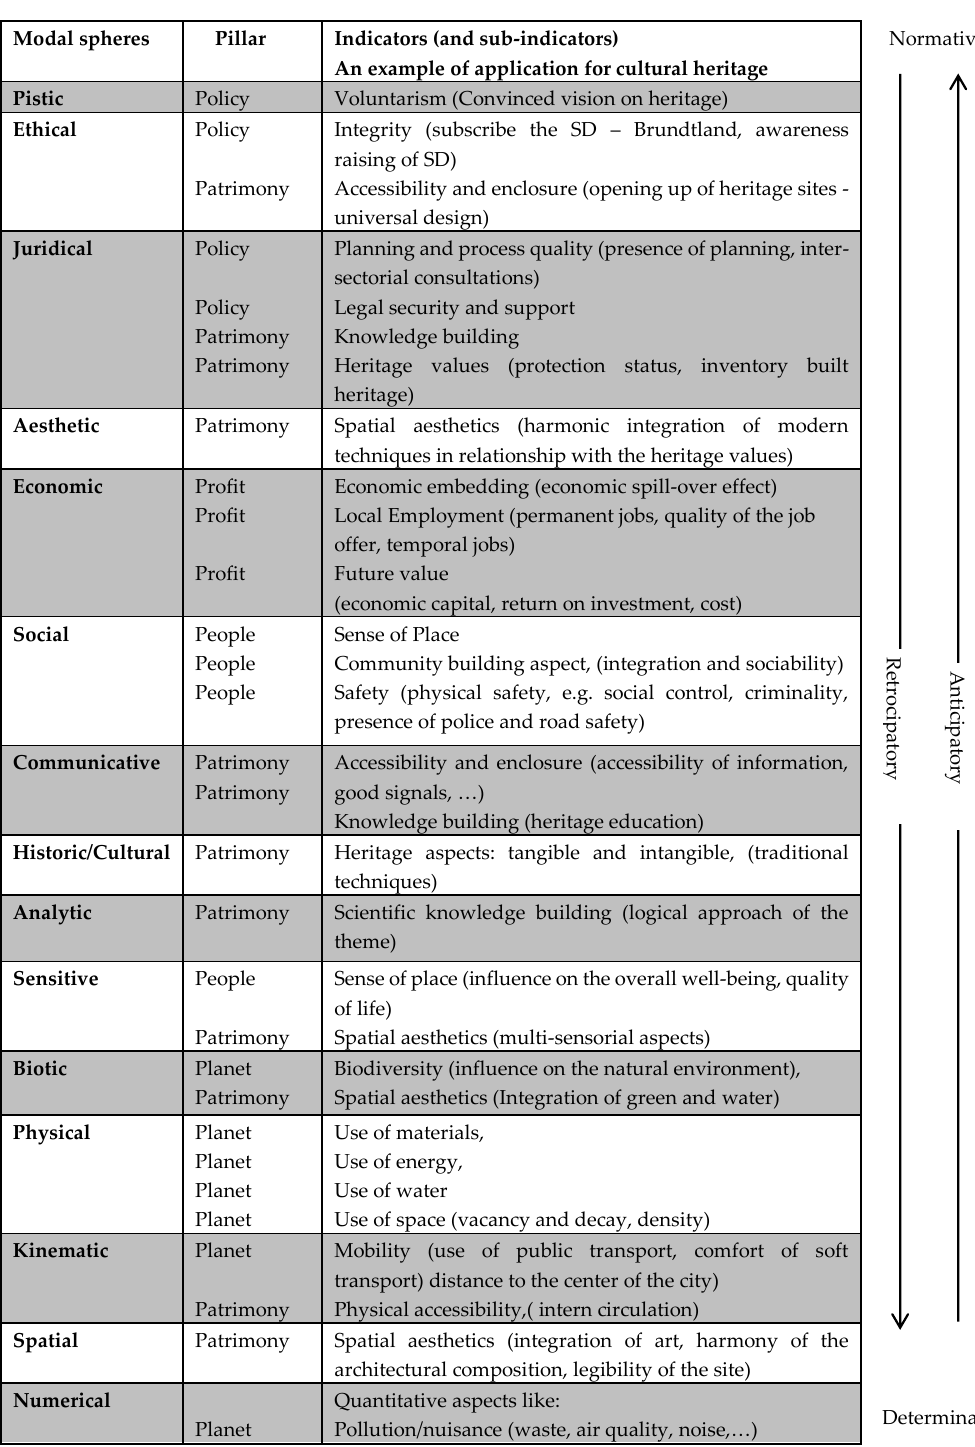
Figure 4. The modal spheres of Dooyeweerd in relationship with the pillars of sustainability and the indicators developed on the scale of historic urban fragments.